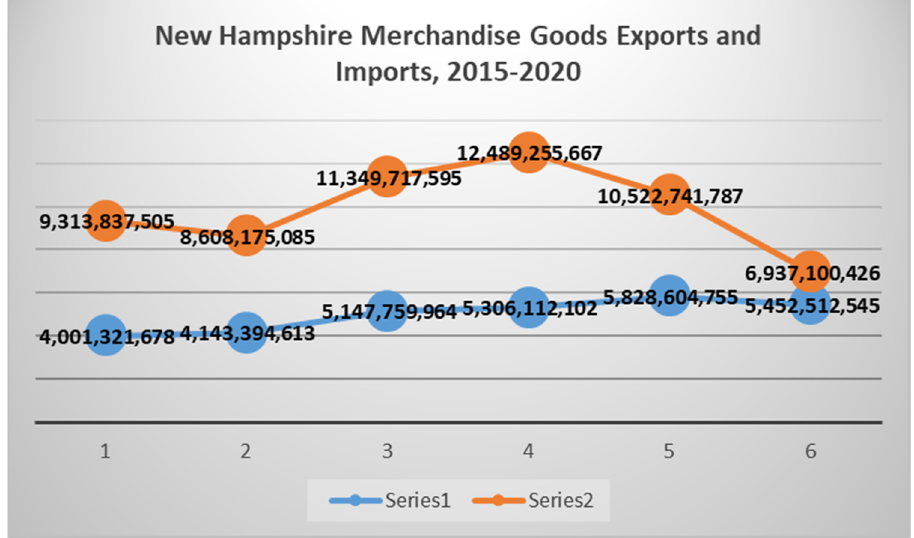
Figure 7. New Hampshire Merchandise Goods Exports and Imports, 2015–2020 Data source: Foreign Trade Division, U.S. Census Bureau.